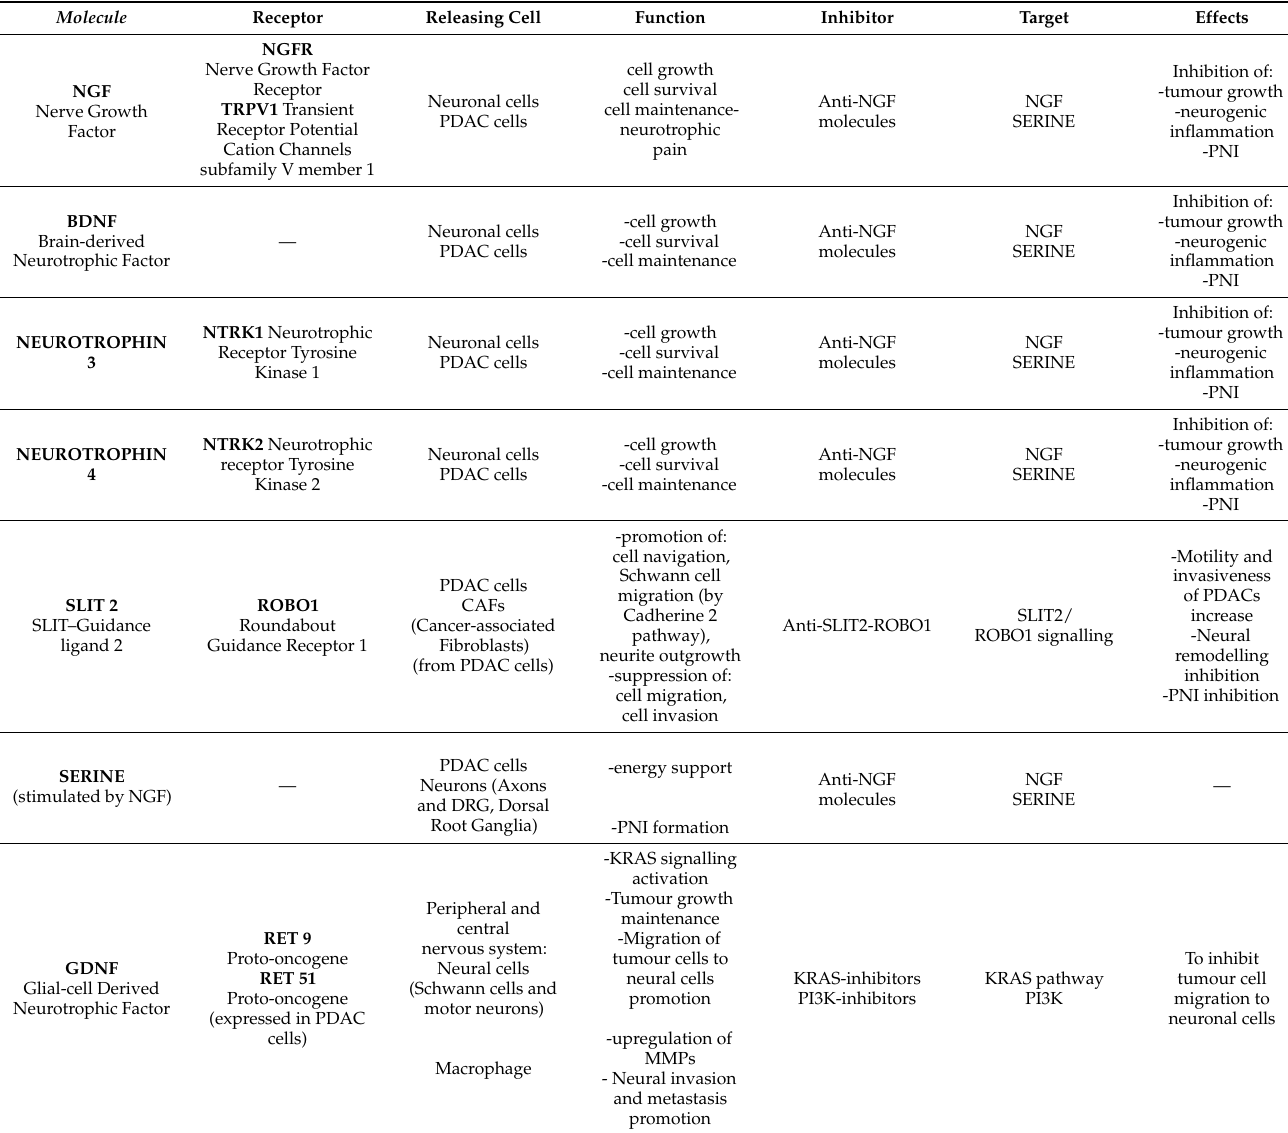
Table 1. Molecular mechanisms of perineural invasion in